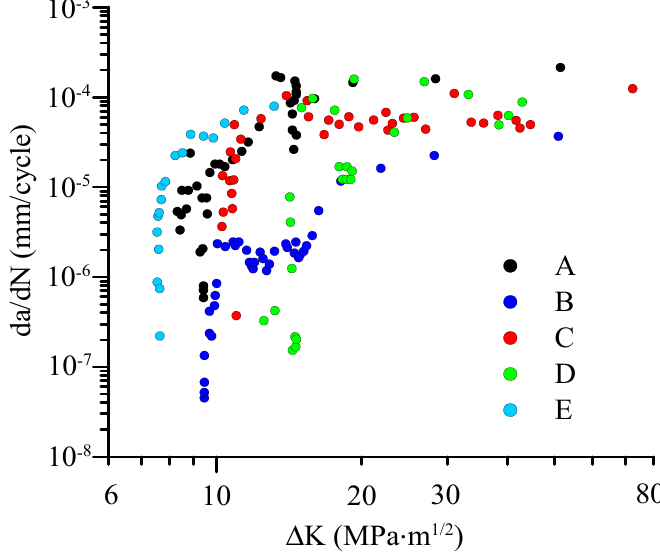
Figure 3. FCRG in five polycrystalline (PC) nickel specimens (A to E).